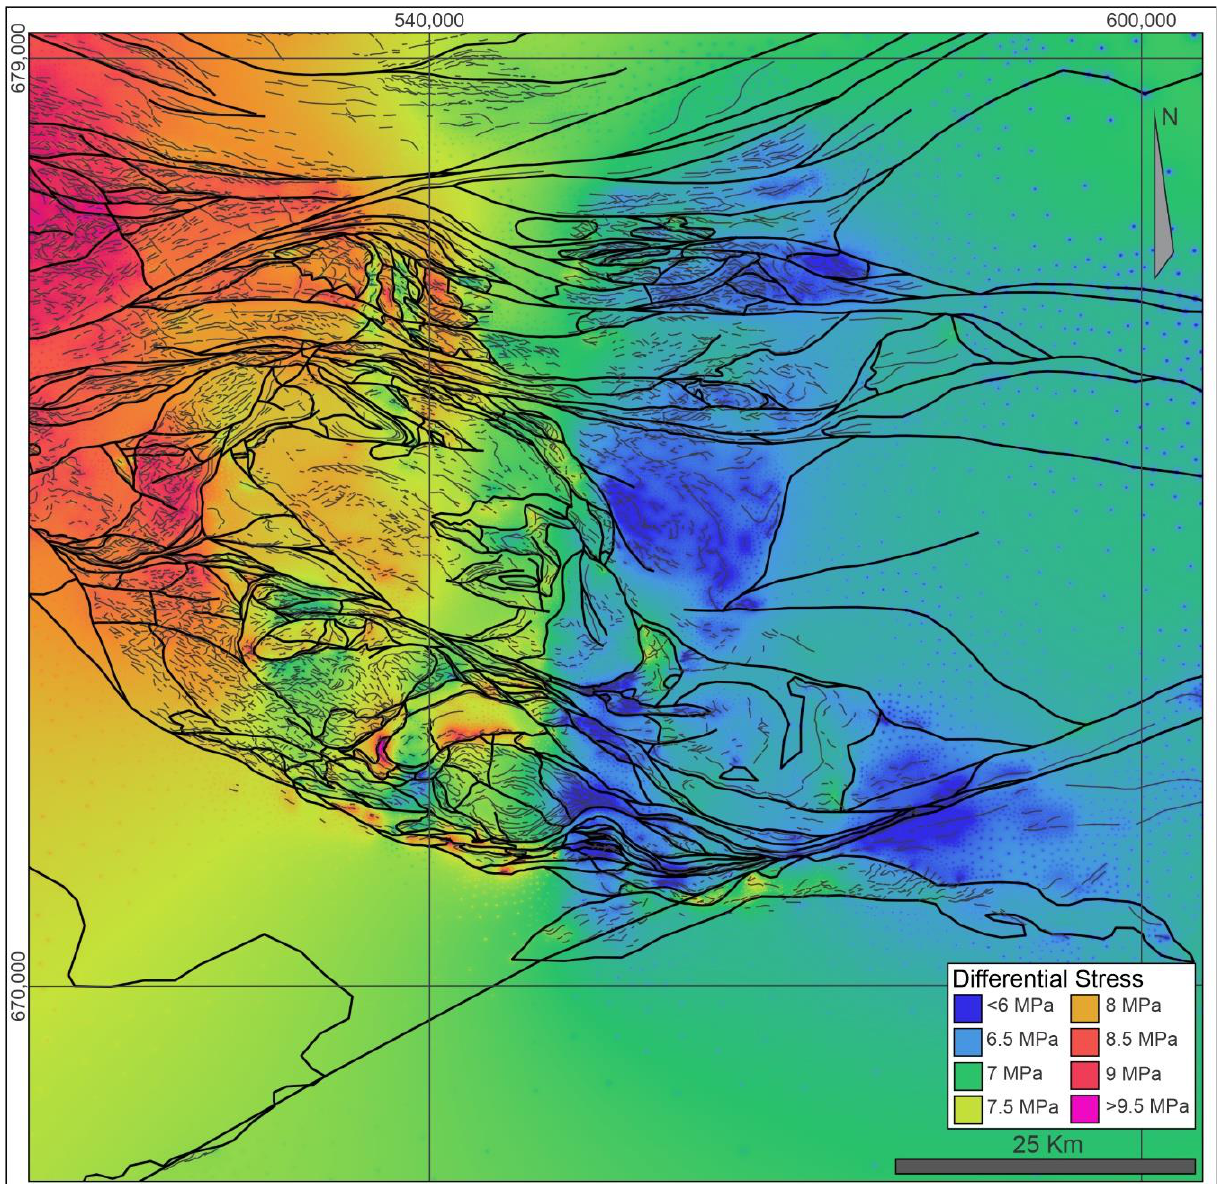
Figure 8. Map illustrating the distribution of differential stress throughout the Mt. Woods Inlier during the simulated stress regime.